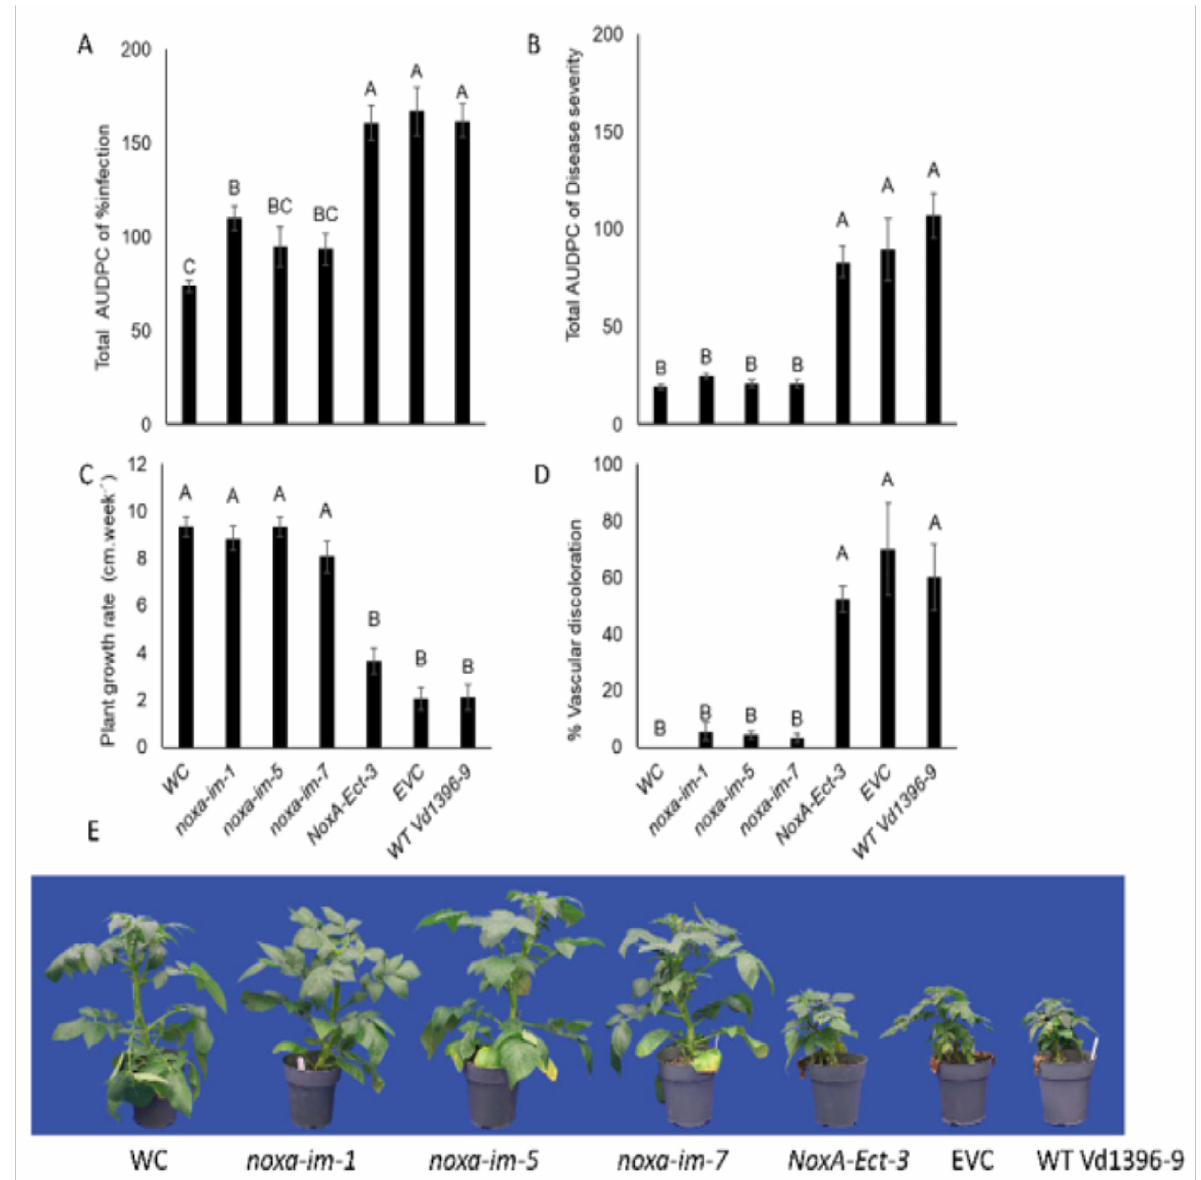
Figure 6. Pathogenicity test of noxa mutants on susceptible potato cultivar (Kennebec) in 2018. ( A ) Total AUDPC of percentage of infection. ( B ) Total AUDPC of disease severity. ( C ) Growth rate of potatoes. ( D ) Percentage of vascular discoloration. ( E ) Kennebec potatoes infected by noxa mutants at 5 weeks after infection. Error bars refer to standard error. The LSD post hoc test was performed to determine which differences are significant among variable means. Bars ( n = 6) with different letters indicate significant differences ( p <